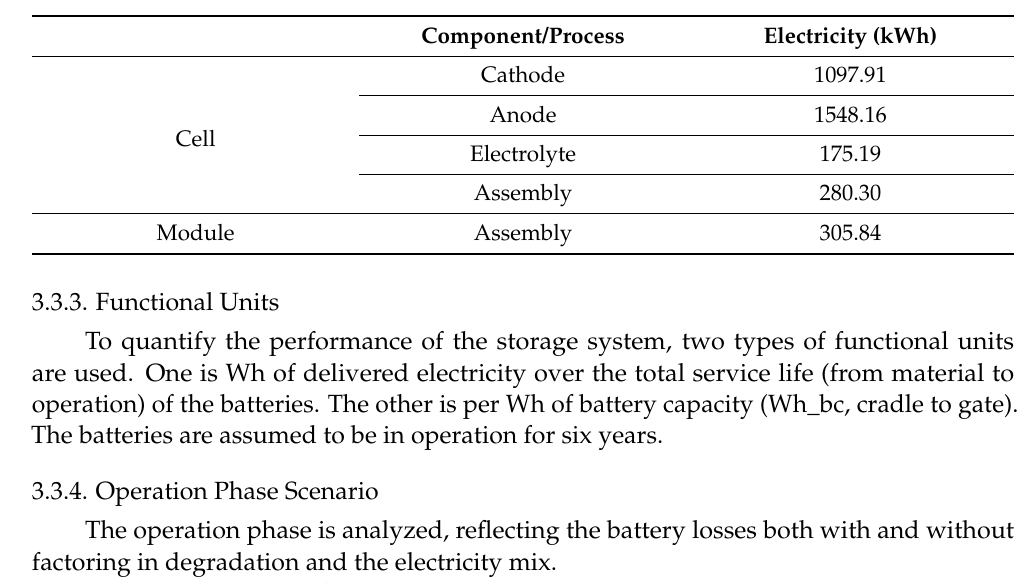
Table 3. Electricity used for